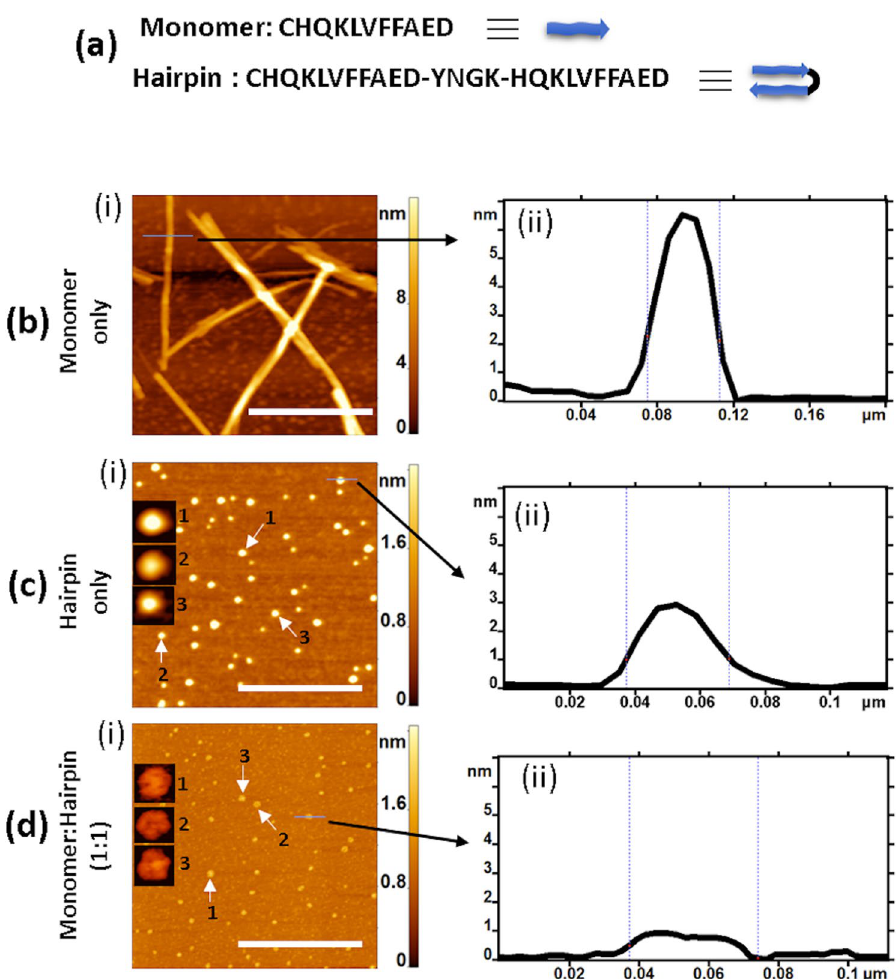
Figure 1. Aggregation study; ( a ) Sequence of A β (14–23) monomer and hairpin. (b , i), ( c , i) and ( d , i) show AFM images of the aggregates from the monomer, the hairpin and the 1:1 mixture of monomer-hairpin, respectively. The insets in ( c ) and ( d ) are zoomed images of the features highlighted by white arrows. The cross section diagrams are shown in ( b , ii), ( c , ii) and ( d , ii) for the selected features (indicated by black arrow) in ( b , i), ( c , i) and ( d , i), respectively. The scale bars are 500